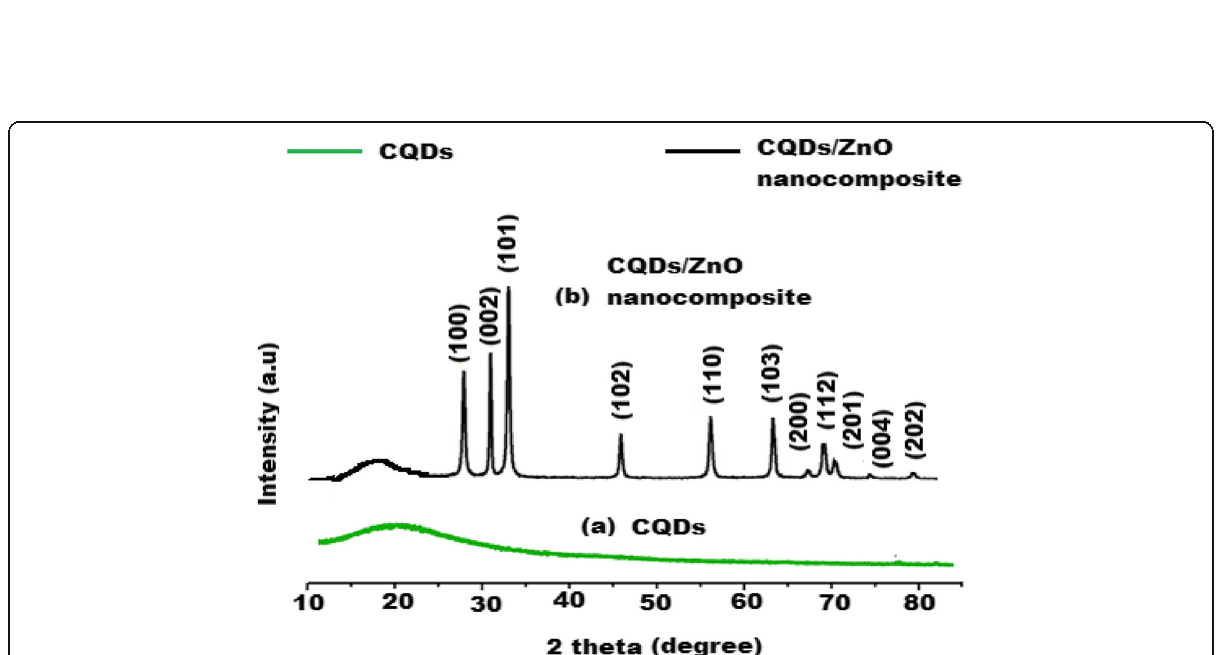
Fig. 7 X-ray diffraction pattern of a CQDs and b CQDs/ZnO